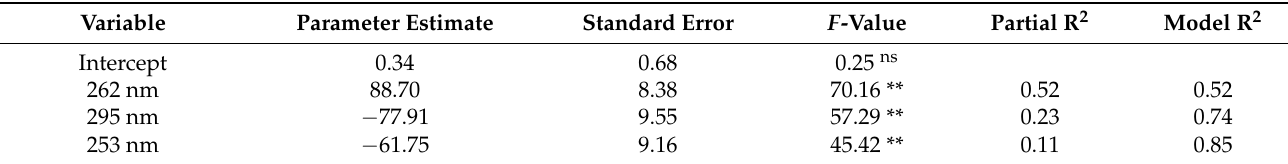
Table 7. Results of stepwise regression between zingiberenoid content as determined by GC-FID and absorbance values from 200 to 350 nm for the BC2F3